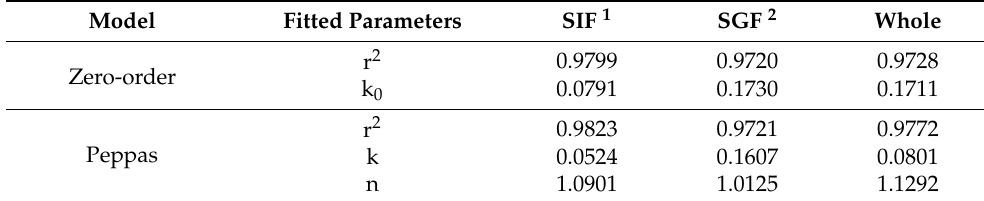
Table 2. Values of fitted parameters by different mathematical models.